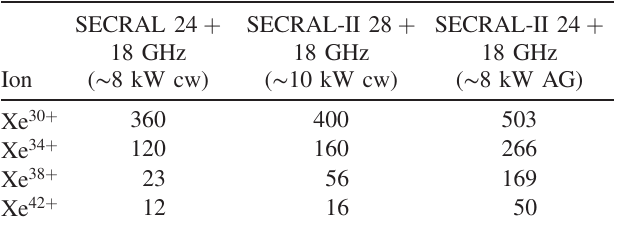
TABLE III. Comparison of xenon beam intensity records between cw and afterglow mode on SECRAL and SECRAL-II ion sources (beam intensity: e μ A).